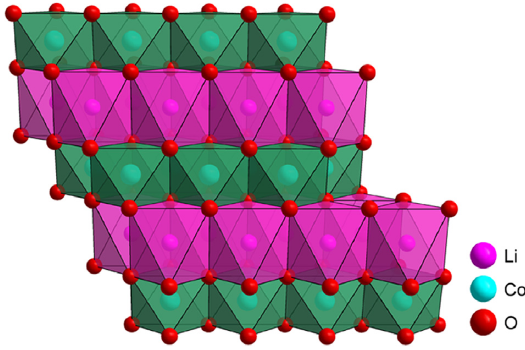
Figure 1. Crystalline structure of layered LiCoO 2 [13].